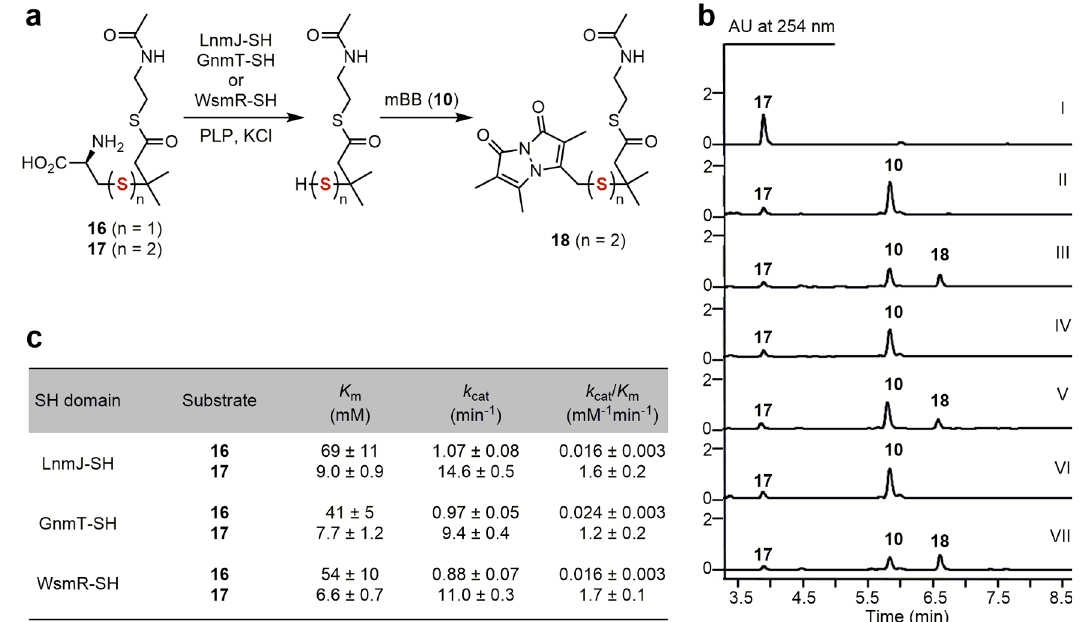
Fig. 4 Characterization of the GnmT-SH, LnmJ-SH, and WsmR-SH domains as thiocysteine lyases installing an -SSH group into varying polyketide scaffolds. a In vitro assay of the three SH domains as thiocysteine lyases using 17 as a substrate mimic, in comparison with 16 as a control for the cysteine lyase activity reported previously for LnmJ-SH. b HPLC analysis of in vitro assays: (I) substrate 17 , (II) 17 + GnmT-SH (boiled) + 10 , (III) 17 + GnmT- SH + 10 , (IV) 17 + LnmJ-SH (boiled) + 10 , (V) 17 + LnmJ-SH + 10 , (VI) 17 + WsmR-SH (boiled) + 10 , (VII) 17 + WsmR-SH (boiled) + 10 , and (VIII) 17 + WsmR-SH + 10 . Substrate and enzyme concentrations used: 17 , 5 mM; GnmT-SH, LnmJ-SH, or WsmR-SH, 30 μ M. Incubation time: 30 min. The concentration of 10 used to trap the resultant hydropersul fi de product in situ as 18 : 2 mM. c Comparison of the steady-state kinetic parameters of the three SH domains for 17 over 16